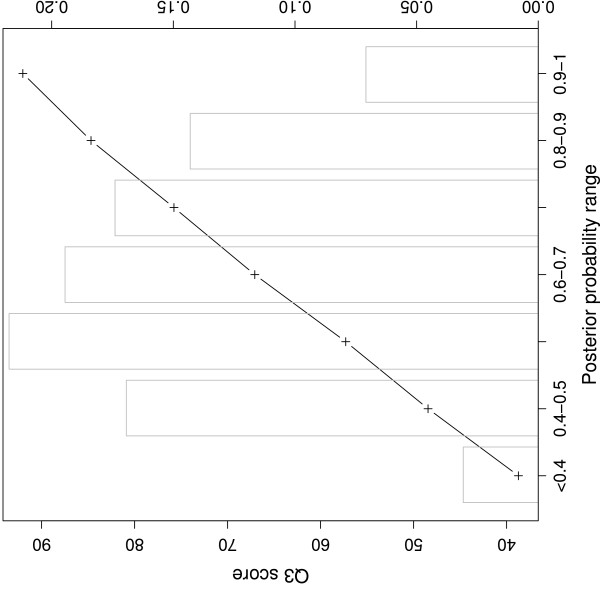
Q3 score as a function of the posterior probability value. The Q3 score is computed on the subset of residues that are predicted with probabilities in given ranges. The distribution of residues in the probability ranges is shown as a gray bar-plot. The right axis is related to this distribution.